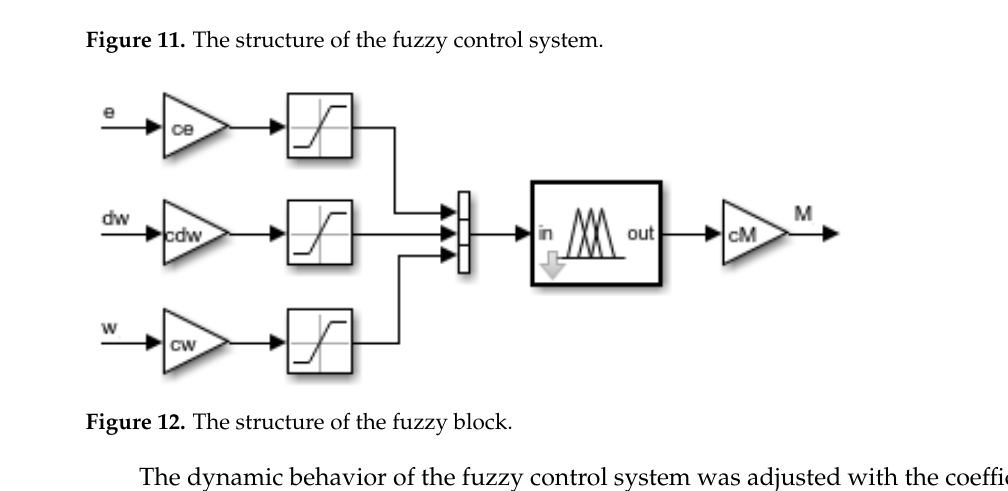
Figure 12. The structure of the fuzzy block.